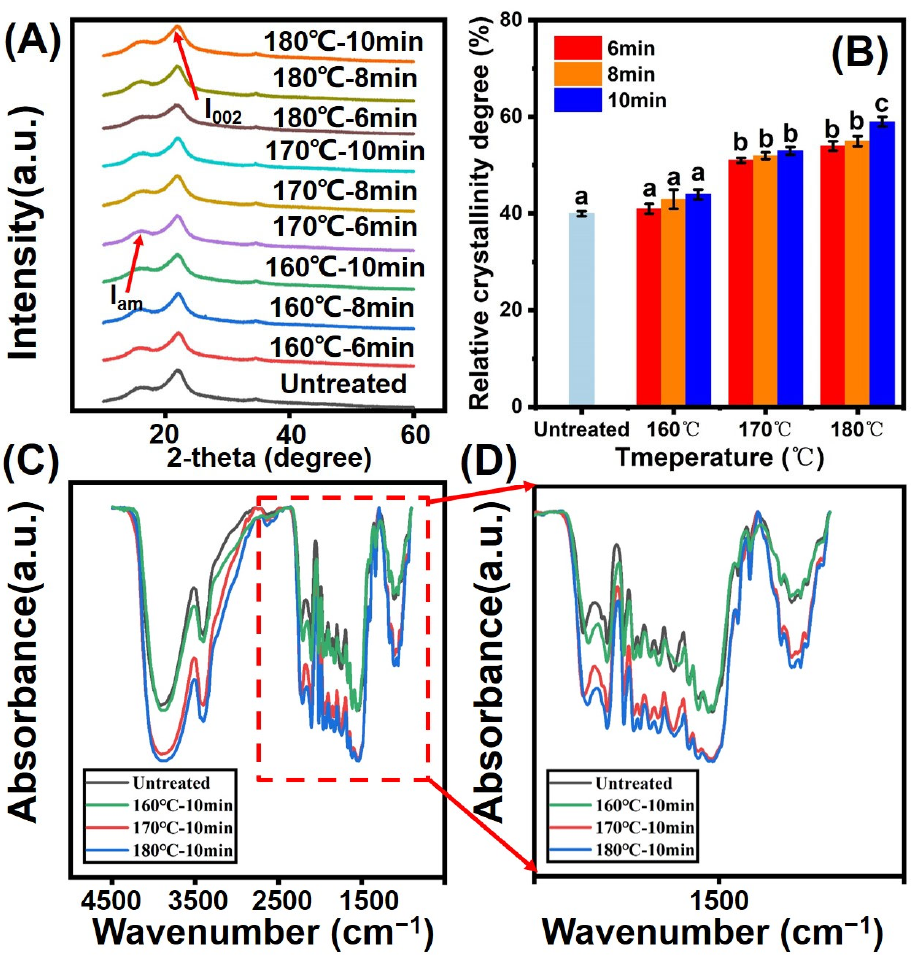
Figure 4. ( A ) XRD patterns of different specimens with the 2-theta angle ranges of 5–60; ( B ) Crystallinity index; ( C , D ) FTIR and enlarged FTIR curves. Different small letters shows significant differences between groups.As shown in ( C , D ), the FTIR curves of untreated and treated bamboo speci ‐ mens from 500 cm − 1 to 4500 cm − 1 were presented. The spectra of different bamboo samples presented the typical peaks of bamboo: 1731 cm − 1 (C=O strength vibrations of hemicellulose), 1230 cm − 1 (C ‐ O strength vibrations peaks), 1590 cm − 1 (stretching of carboxylic acid), and 1425 cm − 1 (strengthening of acetyl acid). It can be seen from the ( C ) that there are no significant differences between the FTIR spectra of untreated and treated bamboo specimens. The relative intensities of peak at 1370 cm − 1 do not change too much due to the stability of C ‐ H, illustrating that C ‐ H can remain unchanged during the thermal modification. The relative intensity of peaks at 1230 cm − 1 and 1730 cm − 1 show decreasing tendency in comparison to that of the control, which was due to the decomposition of the cellulose and hemicellulose in bamboo samples. During the saturated steam heat treatment process, the rel ‐ ative intensity of peaks at 1630 cm − 1 and 1590 cm − 1 increased with the increasing treatment temper ‐ ature. This can be attributed to the increase in lignin content. The condensation reaction of lignin positively contributes to the increase in relative lignin content and can enhance the dimensional stability of the bamboo specimen. Lastly, the relative intensity of peak at 898 cm − 1 obviously de ‐ creased, possibly resulted from acid environment provided by the decomposition of hemicellulose.